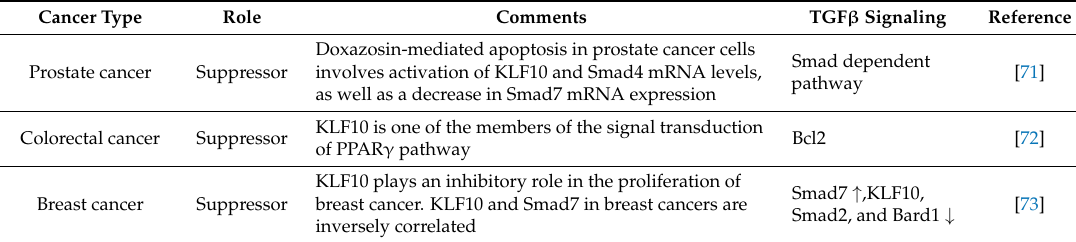
Table 3. KLF10 role in various